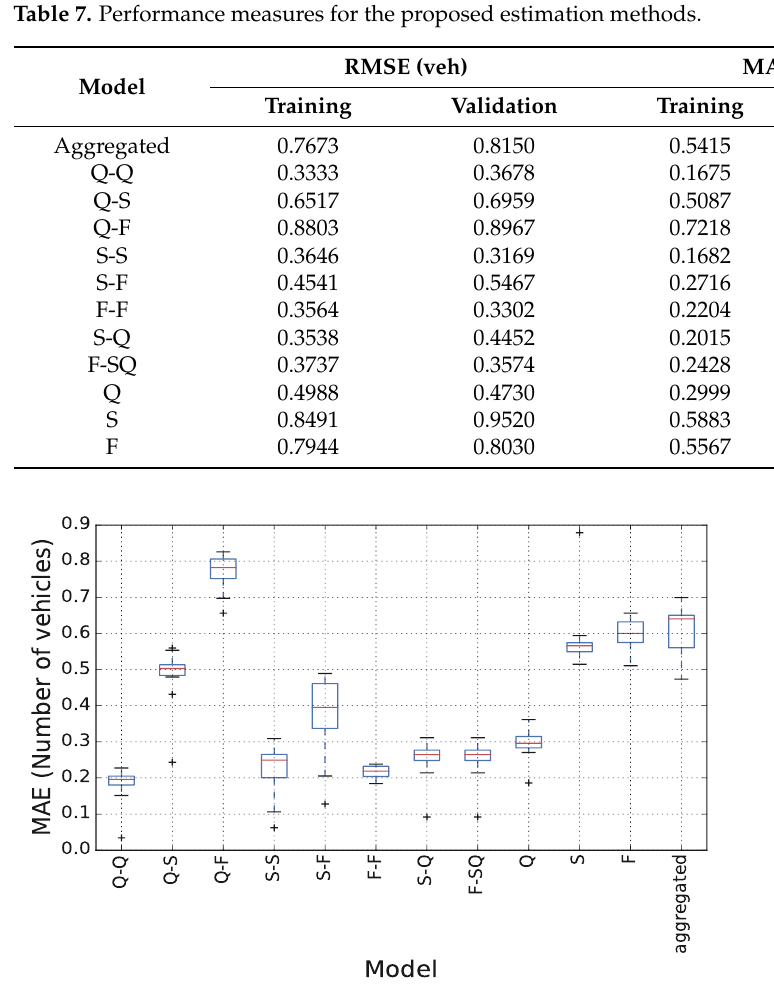
Figure 6. Estimation performance considering different amounts of training